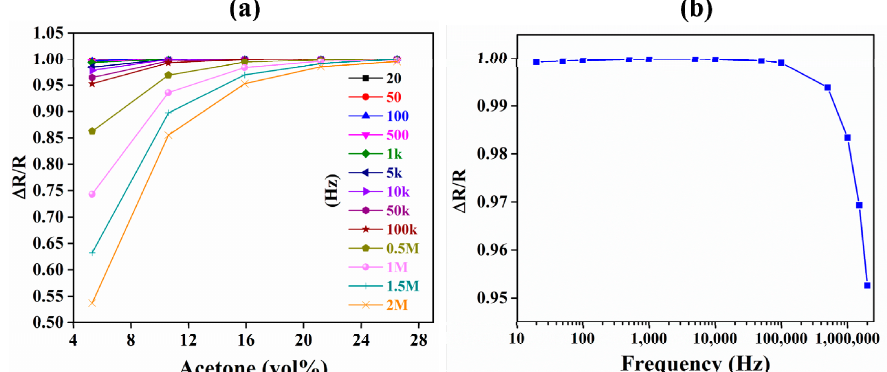
Figure 13. Changes in the device sensitivity vs. actuation frequency for resistive transduction. ( a ) This shows the change in device response at different actuation frequencies. ( b ) This shows the change in device sensitivity with increases in drive frequency at 15.9 vol % of acetone in N 2 .